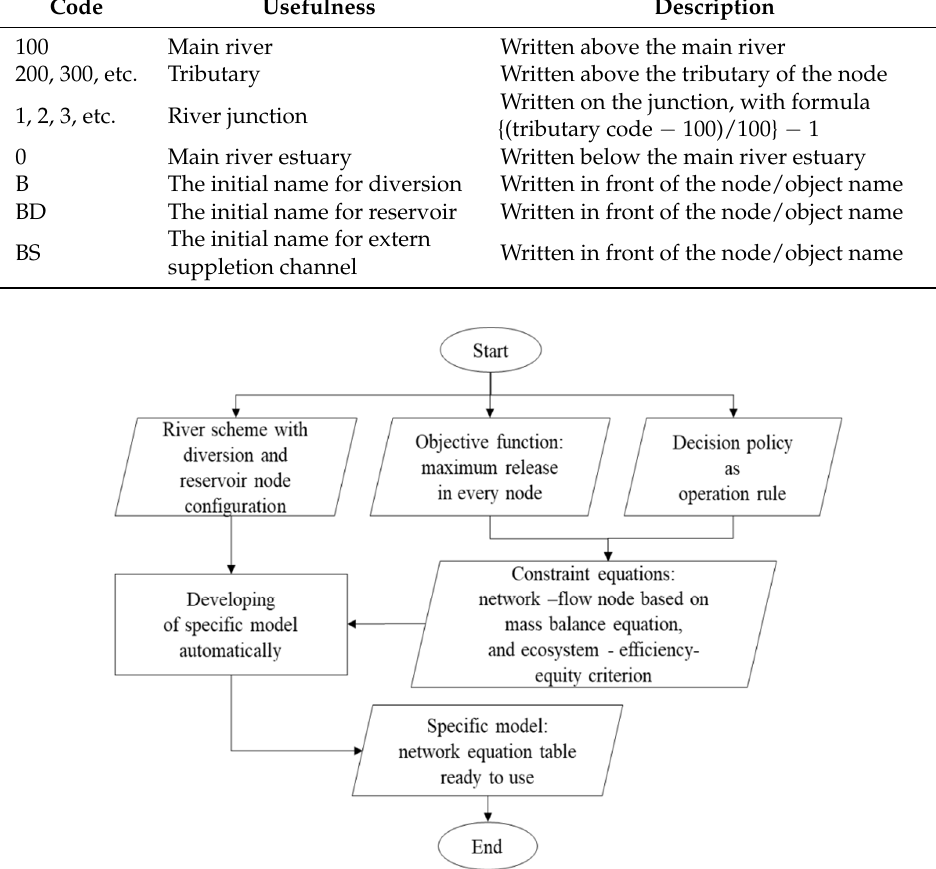
Figure 7. Procedures for the arrangement of the network equation structure.